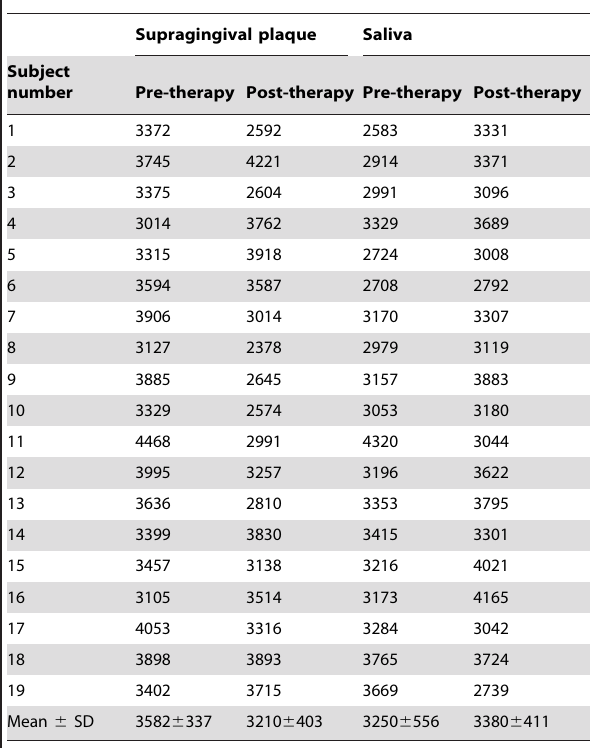
Table 2. Number of sequence reads that passed quality filtering.